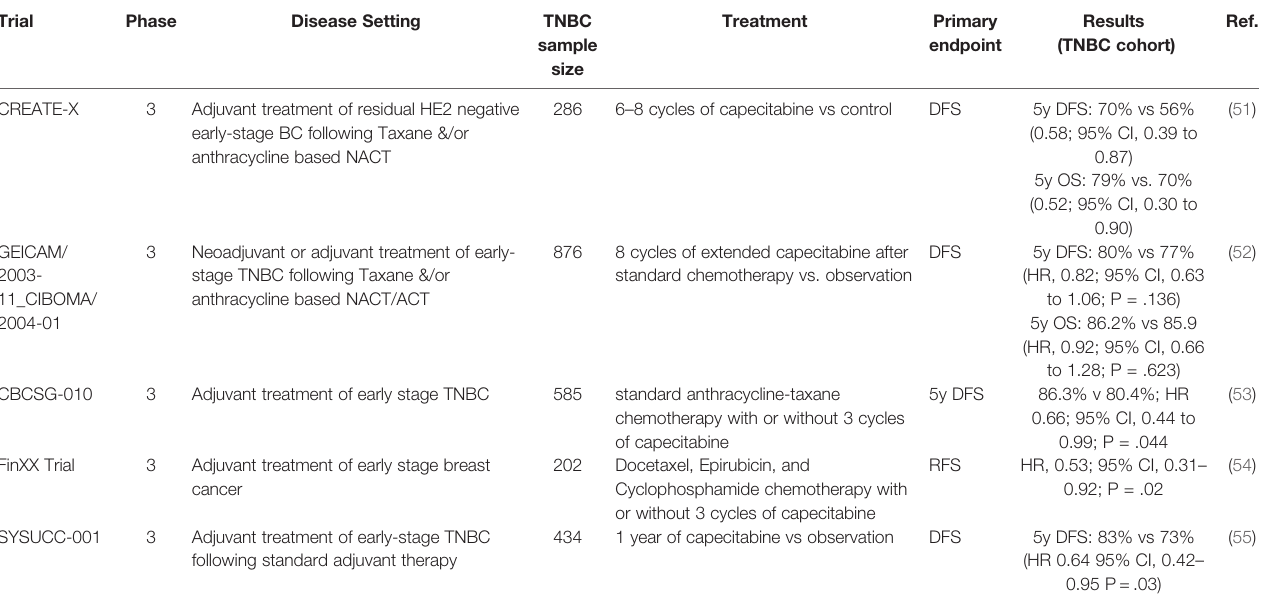
TABLE 4 | Major clinical trials evaluating capecitabine in patients with stage I – III TNBC. Trial